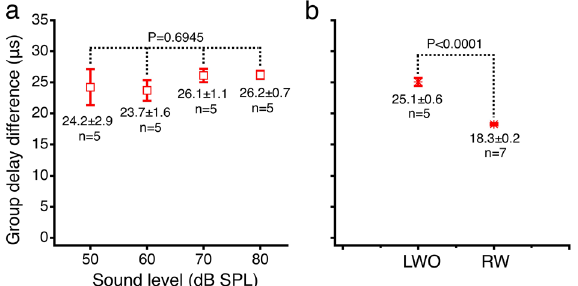
Figure 4. Group delay differences between the reticular lamina and basilar membrane vibration. ( a ), The group delay differences between the RL and BM vibration at different sound pressure levels. A one-way ANOVA showed that there was no statistically significant difference among group delay differences at different sound pressure levels (F(4,20) = [0.4969], p = 0.6945). The data was collected from five sensitive cochleae through the lateral wall opening (LWO) and presented by means and standard errors. ( b ), Means and standard errors of the group delay difference between the RL and BM vibration measured through the LWO and the round window (RW). The group delay difference measured in the transverse direction through the LWO is significantly larger than that measured through the RW (t = 10.4798, p <